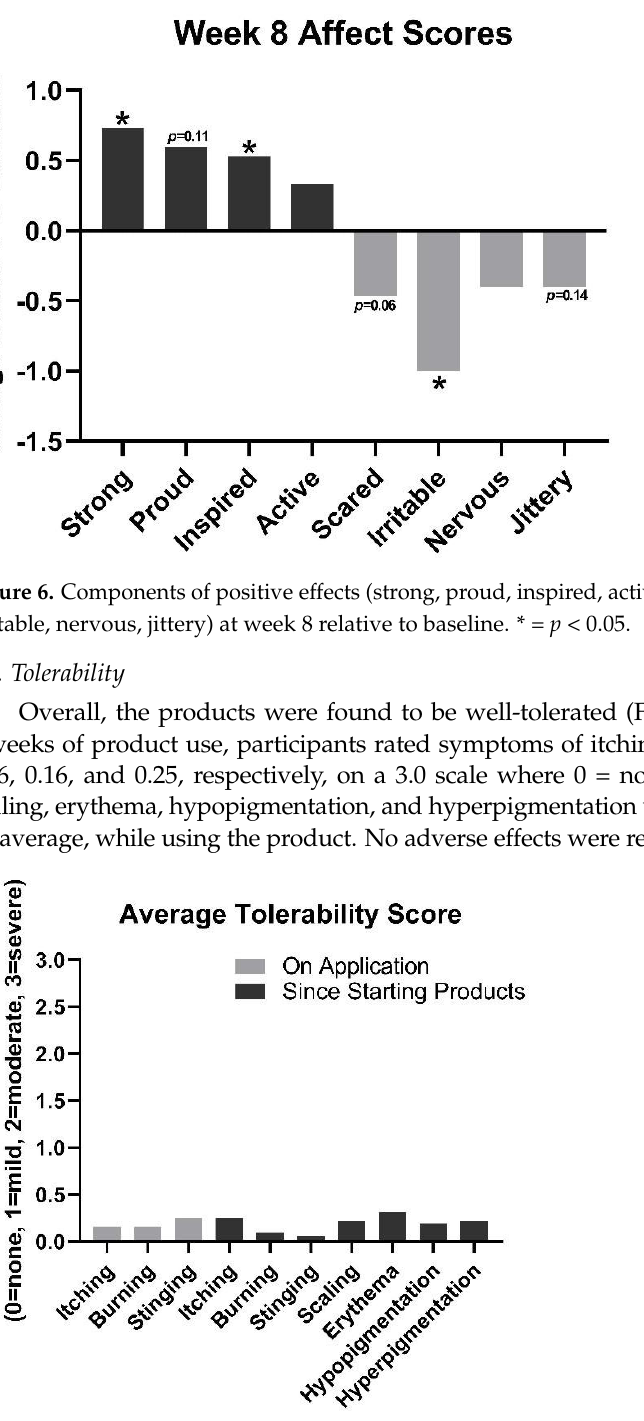
Figure 7. Average tolerability ratings from participants at week